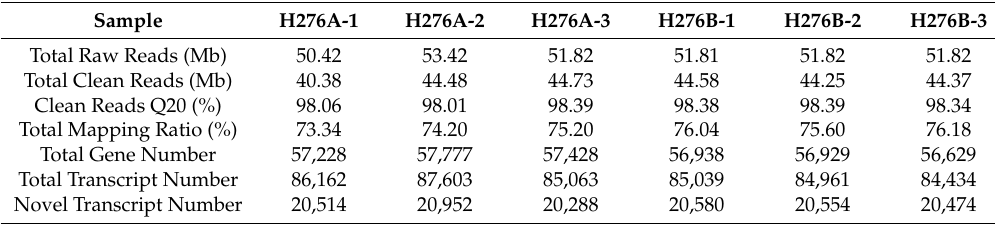
Table 1. Transcriptome sequencing data quality and genome mapping.